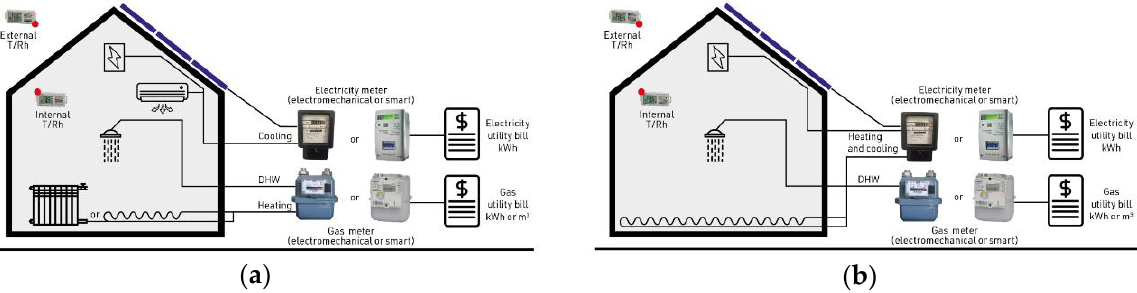
Figure 1. Basic level: ( a ) Configuration 1a: dwelling with independent systems (electrical cooling system and gas heating/DHW production); ( b ) Configuration 1b: dwelling with independent systems (electrical heating/cooling and gas DHW production). Source: elaborated by authors.